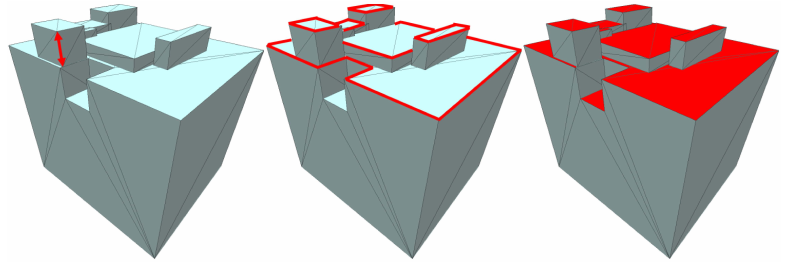
Figure 4. Illustration of roof geometric features. ( Left ): height feature; ( Middle ): edge feature; ( Right ): planarity feature. The features are marked in